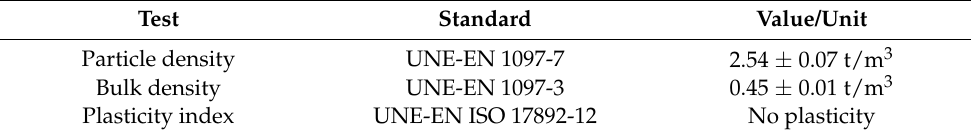
Table 5. Density and plasticity tests for the fine portion of BBA.